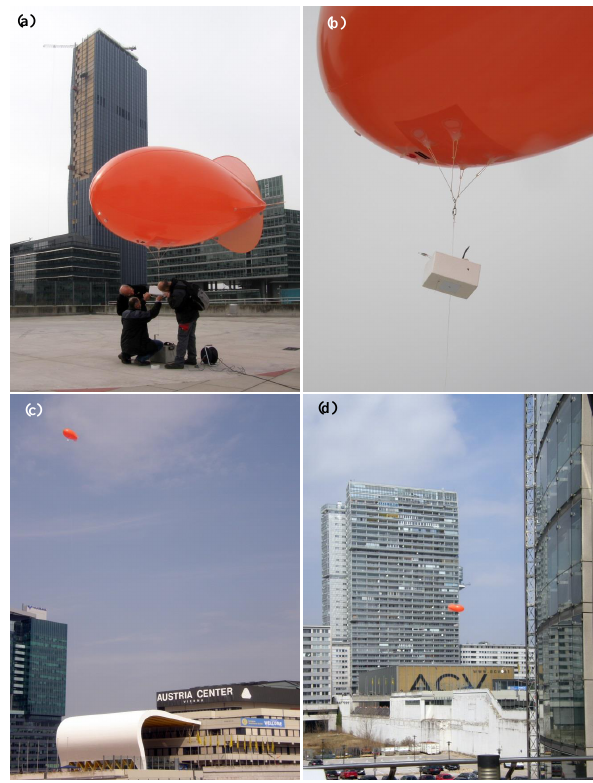
Figure 4. Pictures of the LOAC operations below a 6m 3 tethered balloon at the Austria Center in Vienna during the 2013 European General Assembly. From left to right and top to bottom: (a) prepa- ration of the launch with a view towards the south on a tower un- der final stage of construction in the back; (b) view from below of LOAC in flight with its sampling inlet pointing upward; (c) view from the S of the balloon over the conference centre; (d) view from the south-west of the environment of the launch site including leav- ing and office tower blocks and an open air car park.